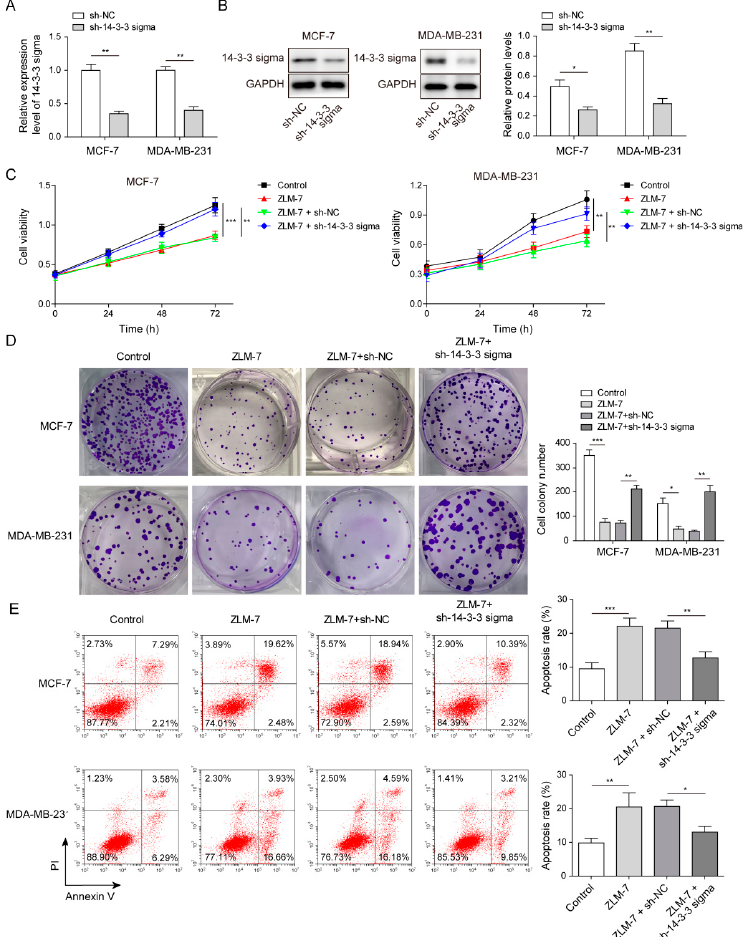
Figure 2. ZLM-7 suppressed cell proliferation and promoted apoptosis by upregulating 14-3-3 sigma in breast cancer cells. ( A ) Relative gene expression of 14-3-3 sigma in MCF-7 and MDA-MB-231 cells transfected with either sh-NC or sh-14-3-3 sigma measured by qPCR. ( B ) Relative protein level of 14-3-3 sigma in MCF-7 and MDA-MB-231 cells transfected with either sh-NC or sh-14-3-3 sigma measured by Western blotting. ( C ) Cell viability at 24 h, 48 h and 72 h measured by CCK8 assay. ( D ) Cell proliferation ability assessed by clone-formation assay in MCF-7 and MDA-MB-231 cells transfected with either sh-NC or sh-14-3-3 sigma. ( E ) Cell apoptosis analyzed by flow cytometry. * p < 0.05, ** p < 0.01, *** p < 0.001.